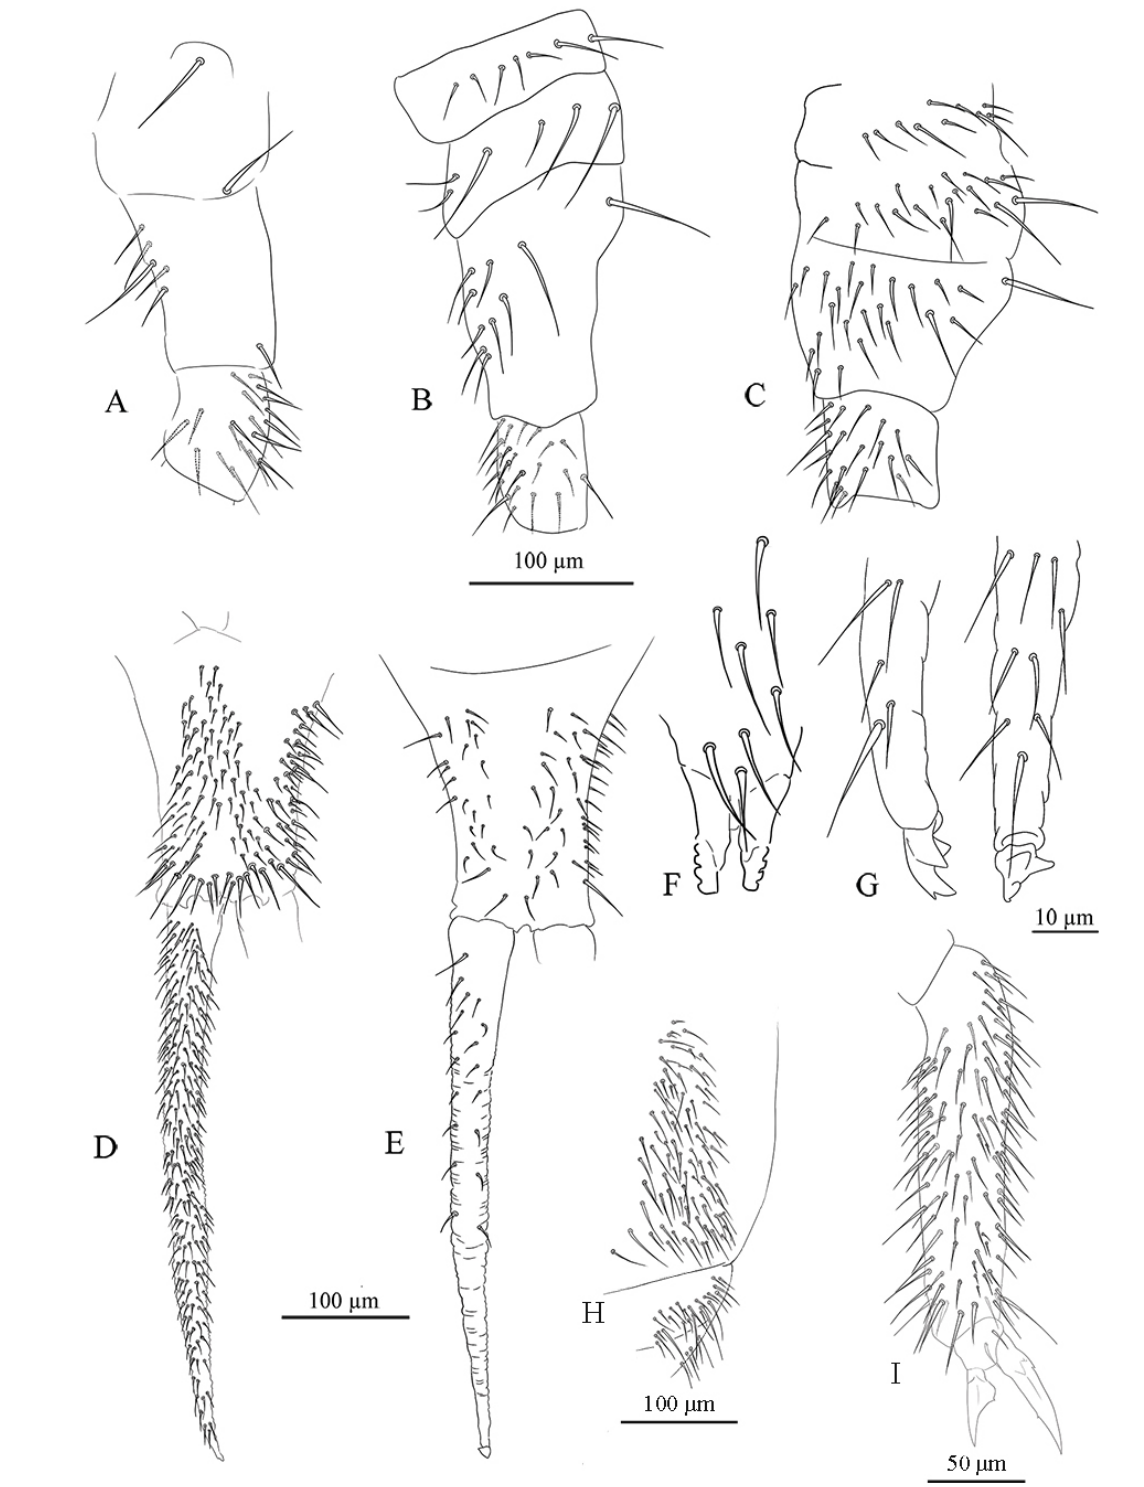
Fig. 3. Desoria calderonis sp. nov . A . Leg I, left; upper and lower subcoxa, coxa and trochanter. B . Leg II, left; upper and lower subcoxa, coxa and trochanter. C . Leg III, left; upper and lower subcoxa, coxa and trochanter. D . Ventral side of furca. E . Dorsal side of furca. F . Retinaculum. G . Mucro and apical part of dens, lateral and dorsal views. H . Lateral part of Abd. IV–V sternites. I . Tita III and Claw